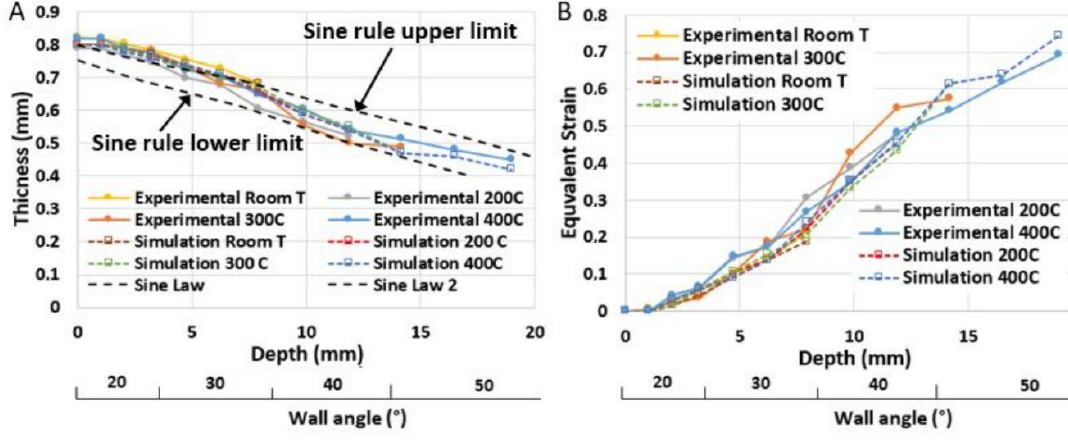
Figure 7. ( A ) Experimentally measured thicknesses. ( B ) Equivalent